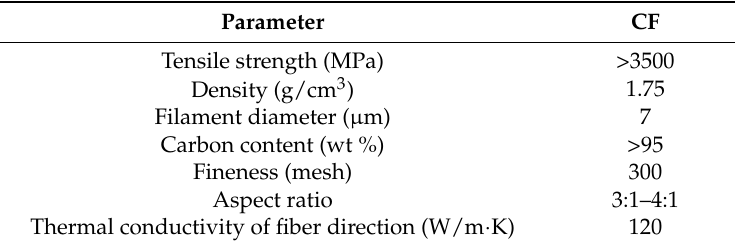
Table 1. The parameters of carbon fiber